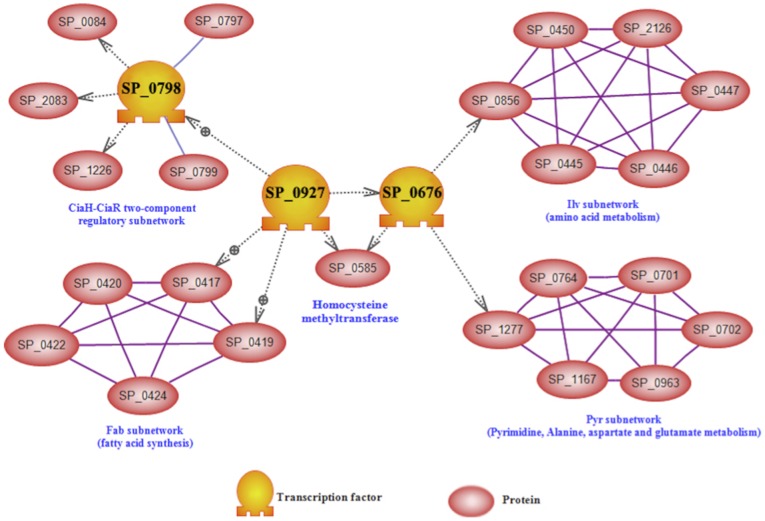
Bioinformatic prediction model for two TFs that potentially contribute to pathogenesis and virulence of S. pneumoniae.
Gene regulatory network analysis of SP_0676 and SP_0927 in the brain versus blood. The interaction network consists of ilv, pyr, fab and cia subnetworks. Dashed arrows represent positive or negative regulation; dashed arrows with a ⊕ sign represents positive regulation.